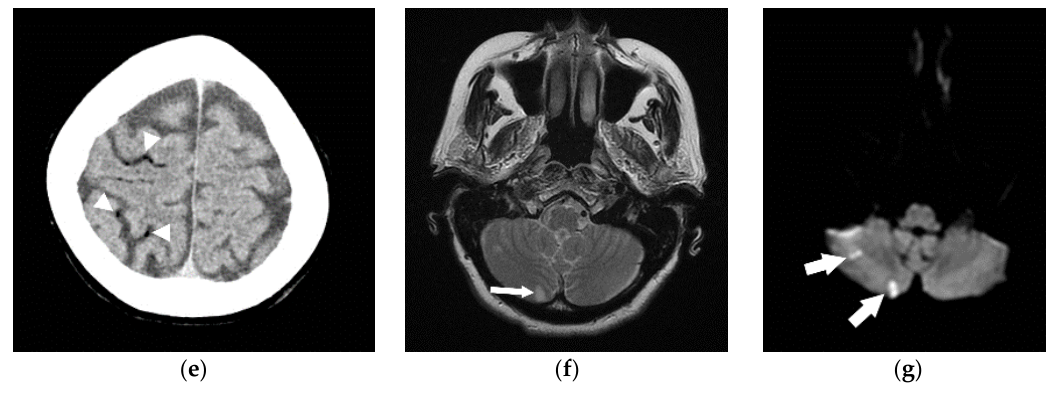
Figure 10. The successful use of a hyperbaric oxygen therapy (HBOT) is outlined in this case, in which a 69 ‐ year ‐ old female with a history of suspected lung cancer underwent a CT ‐ guided lung biopsy at an outside facility ( a ). During the procedure, the patient suffered a cardiorespiratory arrest. An immediate CT ( b ) revealed a right pneumothorax (arrow), together with air in the right pulmonary vein (arrowhead). Additional images from the CT scan ( c , d ), revealed air in the right coronary artery (black arrow), the ascending thoracic aorta (white arrow) and the epidural veins (arrowhead). The patient was initially unresponsive and required cardiopulmonary resuscitation. A non ‐ contrast CT brain ( e ) was performed, revealing air scattered in the vessels overlying the right cerebral hemisphere (arrowheads). Subsequent MRI of the brain confirmed multiple areas of acute infarction in the right cerebral and cerebellar hemispheres. Axial T2 ( f ) and DWI ( g ) images of the brain demonstrated acute areas of infarction in the right cerebellum. The patient required ICU management and